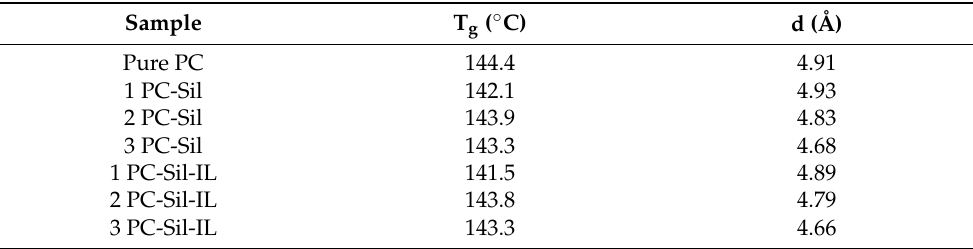
Table 3. Glass transition temperature (T g ) and d -spacing of the developed membranes.